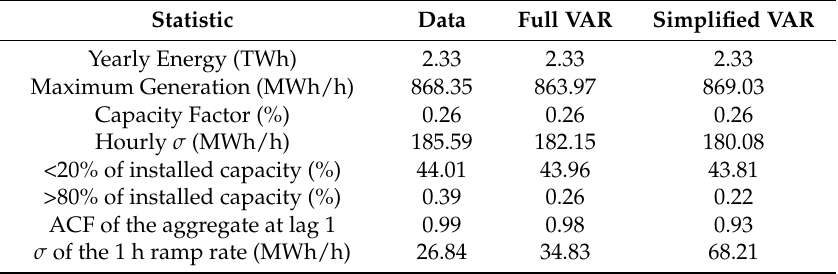
Table 1. The numerical statistics estimated from the measured aggregated wind power generation in Finland in 2015 and from the aggregated simulated data from the two models. σ stands for standard deviation and the capacity factor is the ratio between installed capacity (calculated with the maximum installed capacity at the end of 2015) and the actual output. The <20% and >80% rows show the percentage of hours in a simulation run when the aggregated generation is within the limits. The presented statistics estimated from the simulation results are averages of the 100 MC runs.